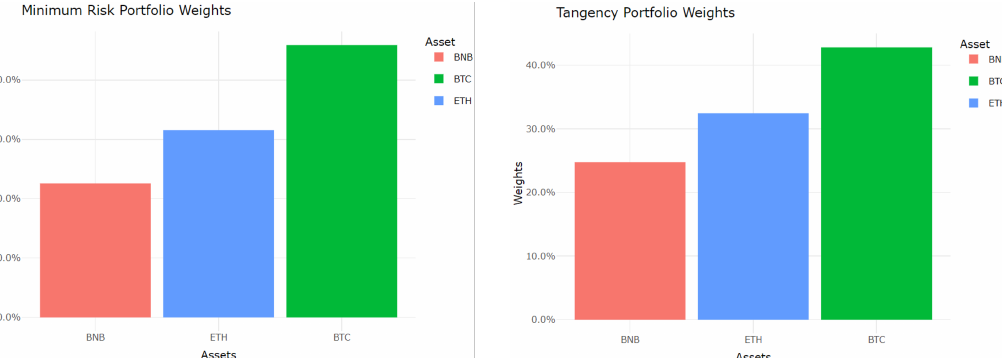
Figure 11. The asset weights assigned using MRP-VESV and MMRP-VESV for Cryptocurrency (Group 1) assets.